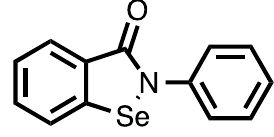
Figure 1. Ebselen. Figure 1.